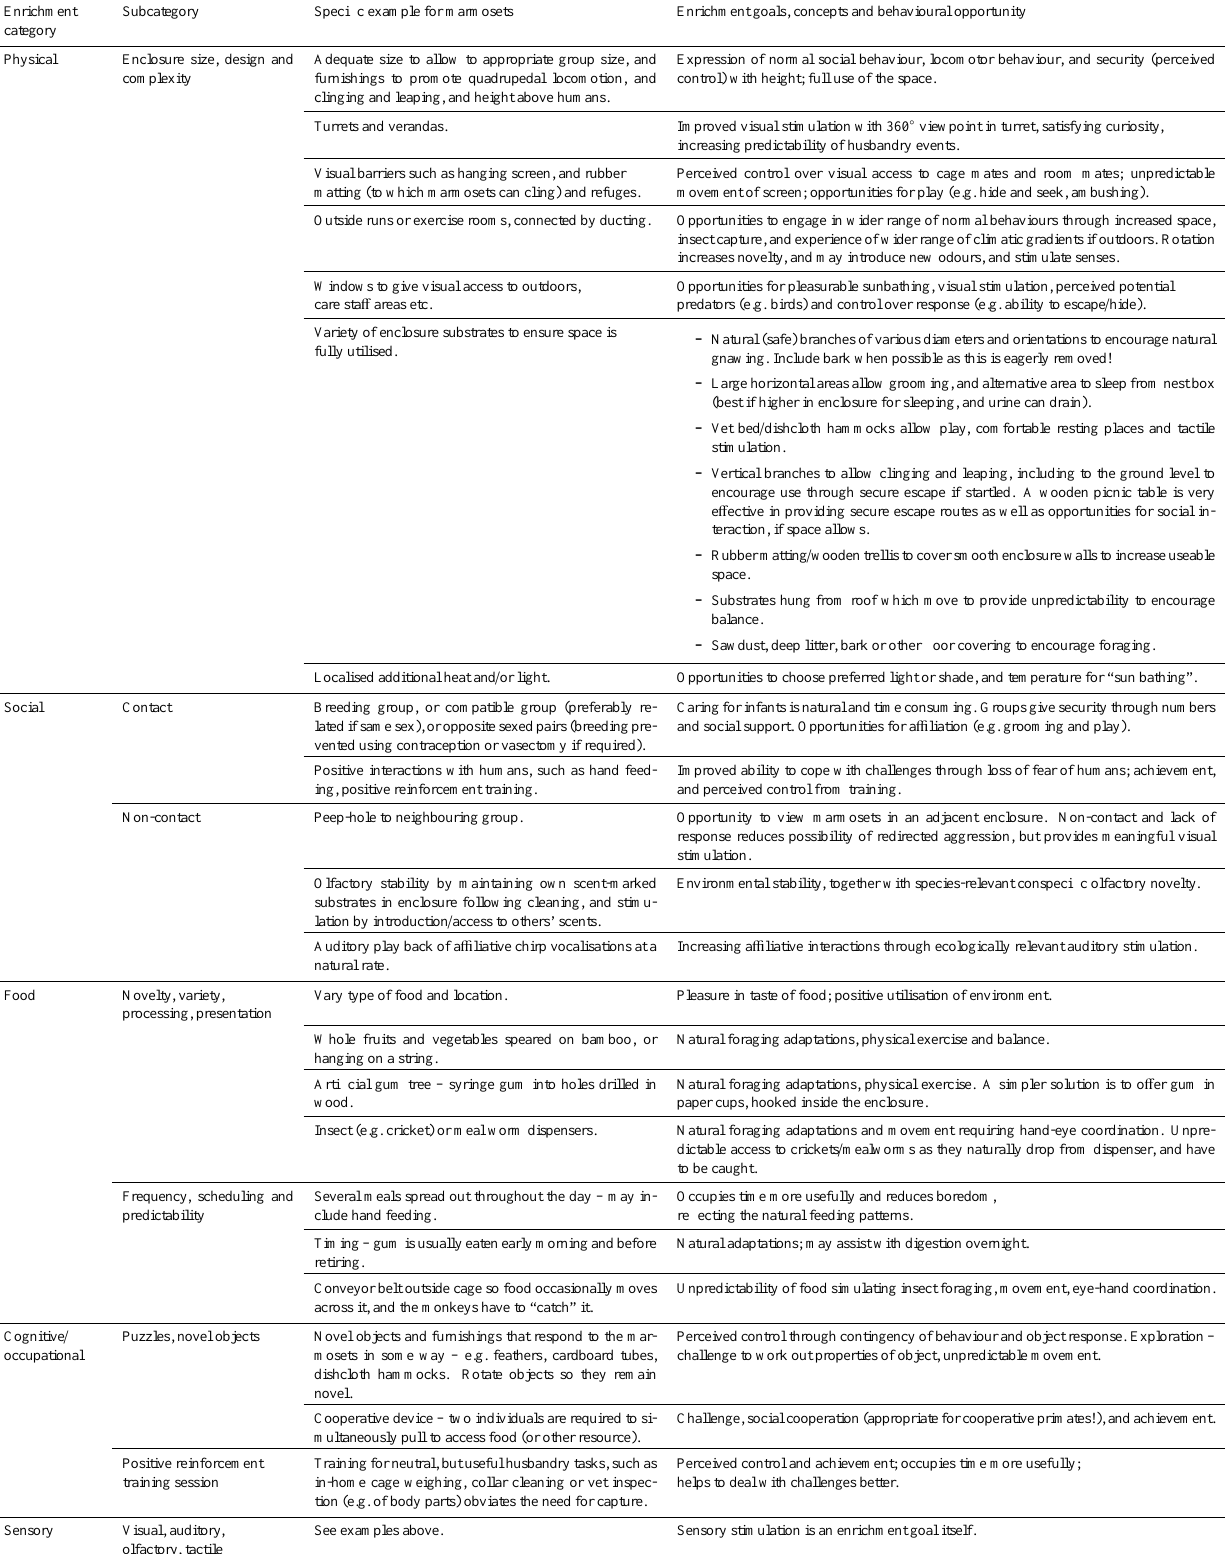
Table 2. Examples of applying the di ff erent enrichment categories (see Fig. 1) to common marmosets. Note that all examples include increasing complexity, and hence choice, as an enrichment goal. Enrichment